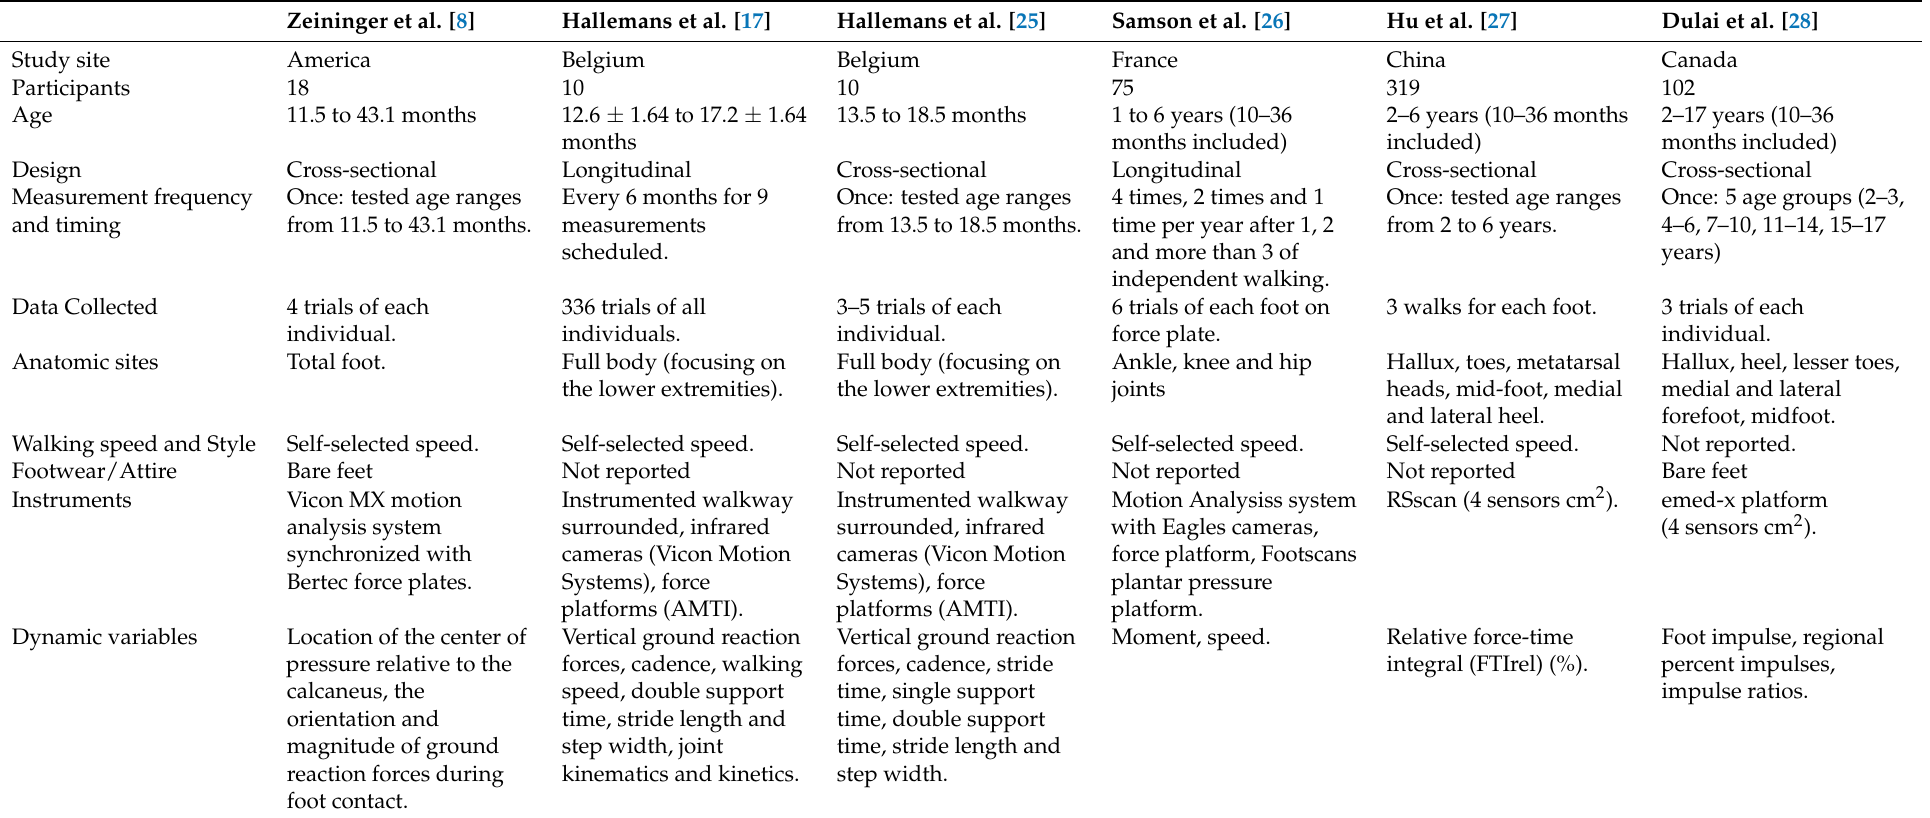
Table 2. Literature relating to kinematic and kinetic parameters of toddler